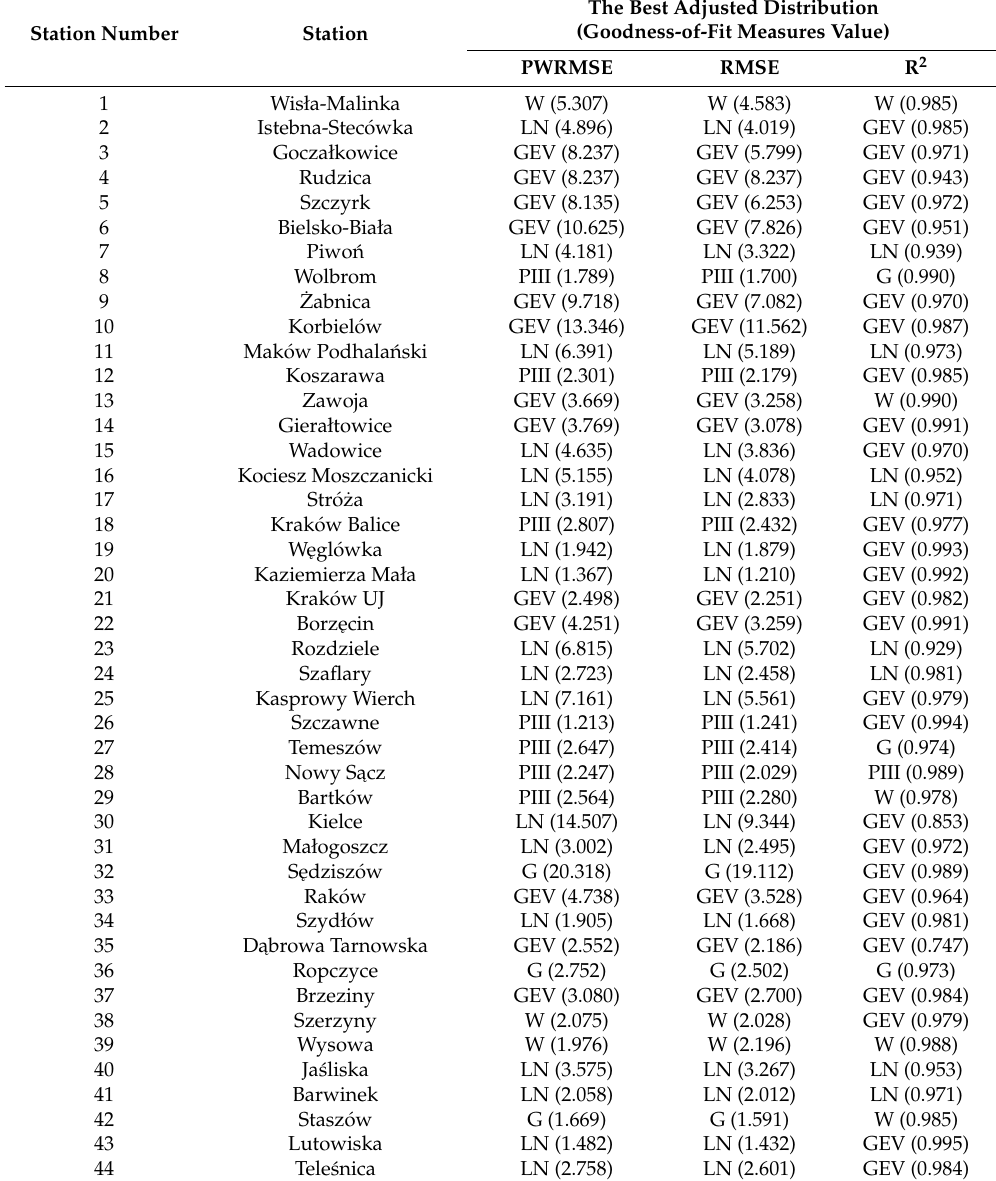
Table 2. Values of the analyzed goodness-of-fit measures matching the theoretical distributions. Station